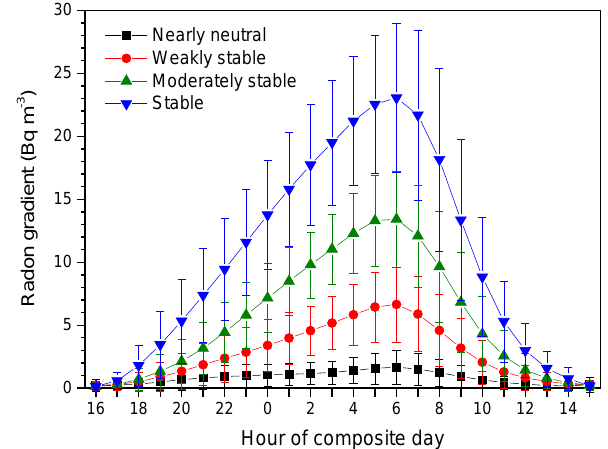
Figure 7. Hourly mean diurnal composite radon gradient plots for the four designated nocturnal stability categories. Each curve repre- sents an average of between 410–420 whole days of observations; whiskers represent ± 1 σ